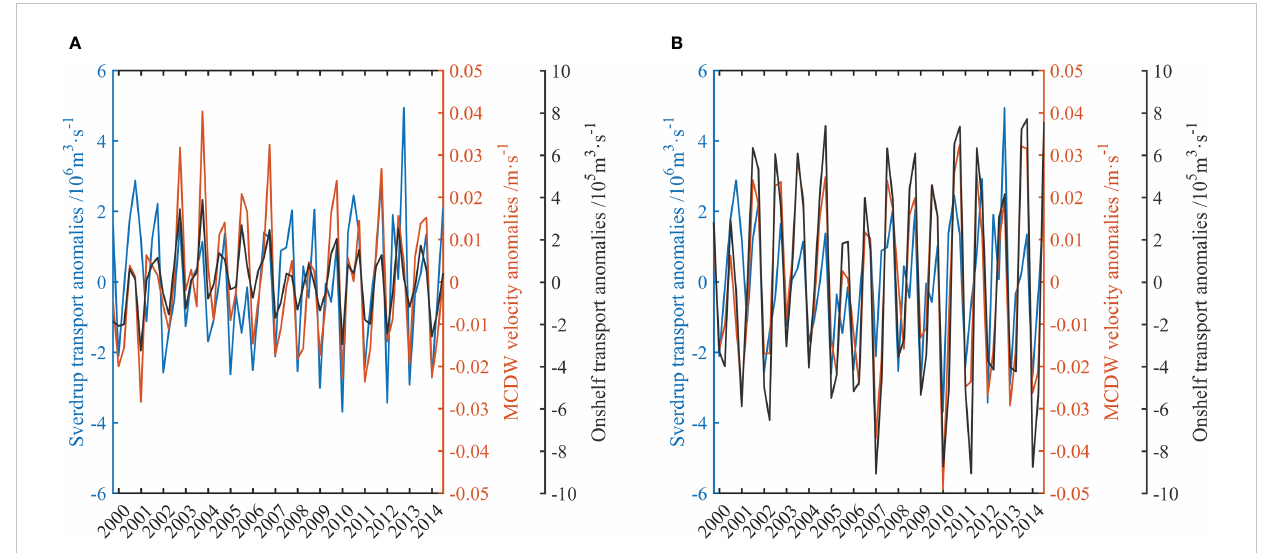
FIGURE 10 (A, B) Time series of depth-transect averaged along-transect component of seasonal velocity anomalies within the MCDW layer (red lines) between 200 and 400 m along Transects 3 and 5, respectively; on-shelf components of seasonal transport anomalies (black lines) on the eastern DT and JT; and seasonal Sverdrup transport ( V sv ) anomalies (blue lines) within the western off-shelf area. The negative values represent on-shelf or southward. The correlation coef fi cients and p-values between these three time series are shown in Table 2. MCDW, Modi fi ed Circumpolar Deep